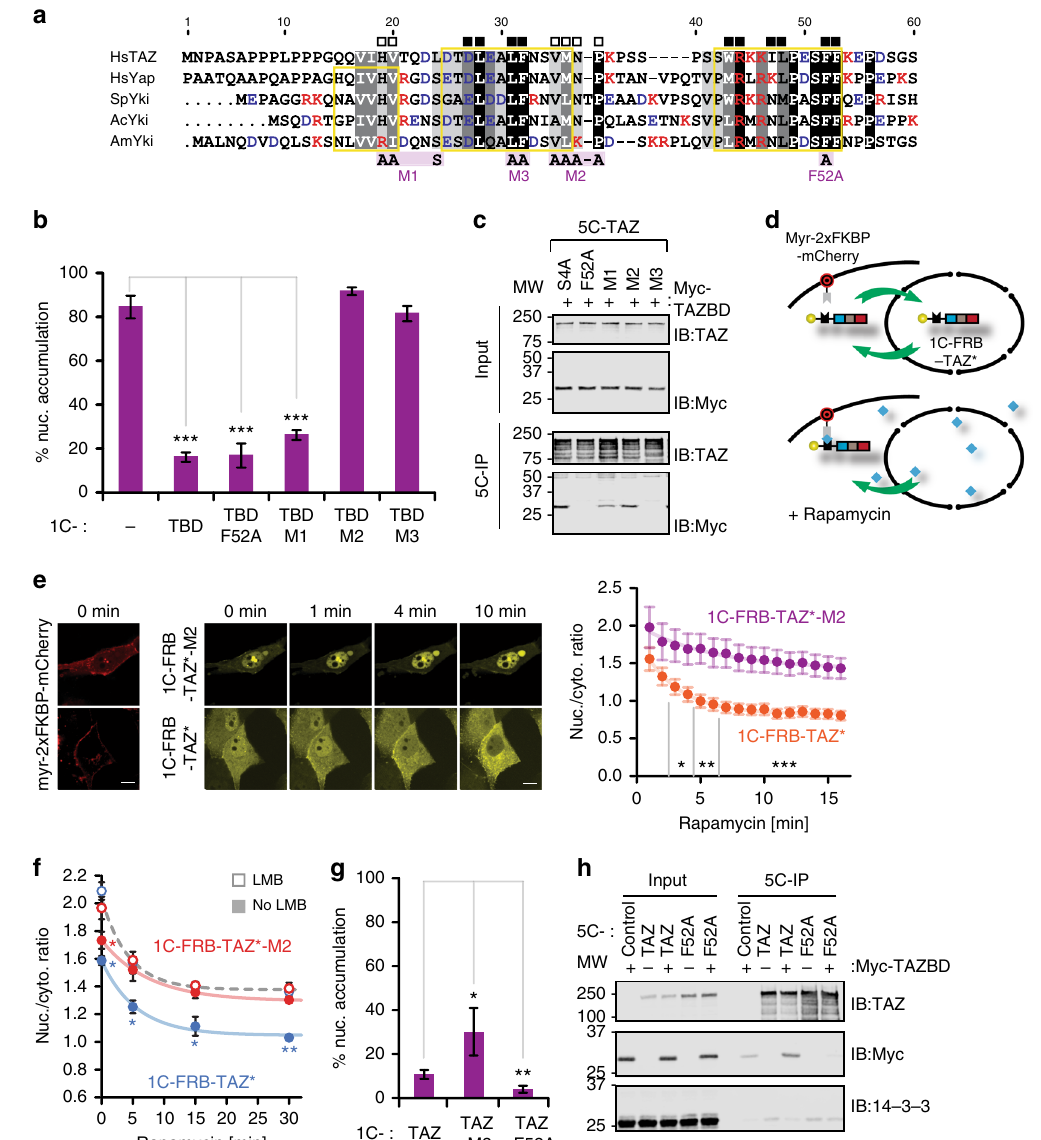
Fig. 8 The TBD comprises a NES within the TEAD-binding site. a Sequence alignment of TBDs from TAZ homologs, as in Fig. 5b. Positively charged residues are depicted in red. Filled and open boxes (above alignment) highlight important or dispensable positions for TEAD binding, respectively 25 . TEAD- binding sites are boxed in yellow 54, 55 . Mutations used in this study are shown below. b Nuclear enrichment of 1C-TBD mutants, presented as mean ± SD, n = 3. c Impact of TBD mutations on TEAD binding. 5C-TAZ constructs and the Myc-TAZ binding domain of TEAD1 (TAZBD) were co-expressed. 5C- constructs from lysates were immunoprecipitated with GFP-trap beads. TAZ and Myc-TAZBD were detected in lysate (input) and immunoprecipitates (5C-IP) by western analysis using TAZ- and Myc-speci fi c antibodies, respectively. d RIS ’ C model showing rapamycin-induced cytoplasmic entrapment of 1C-FRB-TAZ 4SA F52A (1C-FRB-TAZ*) by myristoylated-2xFKBP-mCherry. e RIS ’ C assay using live-cell imaging. Cells expressing Myr-2xFKBP-mCherry and 1C-FRB-TAZ* or 1C-FRB-TAZ*-M2 were imaged confocally. After the fi rst image (t = 0 min), rapamycin was added and further images were taken. Scale bar: 10 μ m. Average R N/C values ± SEM are plotted against time. 1C-FRB-TAZ*, n = 43 cells, 1C-FRB-TAZ*-M2, n = 29 cells. Signi fi cant differences between the two probes are indicated in time-intervals. Fits represent an exponential decay to minimum function. f LMB sensitivity of nuclear export. Experiments and fi ts were performed as in ( e ), with or without additional LMB treatment (open and closed circles) for 80 min. Median R N/C values of 1C- FRB-TAZ* (blue) and 1C-FRB-TAZ*-M2 (red) are presented as means ± SD, n = 3. Curves correspond to an exponential decay function. In the presence of LMB, the decays of nuclear accumulation of the constructs are indistinguishable (single fi t; black dotted curve). Blue and red asterisks indicate minimum signi fi cance levels of 1C-FRB-TAZ* relative to all other conditions and 1C-FRB-TAZ*-M2 relative to LMB-treated samples, respectively. g Nuclear enrichment of 1C-TAZ constructs with mutations in the TBD, presented as means± SD, n = 4. h Competition between TAZBD and 14 – 3 – 3 for TAZ binding. 5C-control and 5C-TAZ constructs were co-expressed with or without Myc-TAZBD, immunoprecipitated with GFP-trap beads, and analyzed by western blotting using TAZ-, Myc-, and 14 – 3 – 3 speci fi c antibodies. Note weak, unspeci fi c binding of Myc-TAZBD to 5C-control. Uncropped versions of blots are shown in Supplementary Figure 1C and 1D. * p < 0.05, ** p < 0.01, *** p < 0.001; Student ’ s t